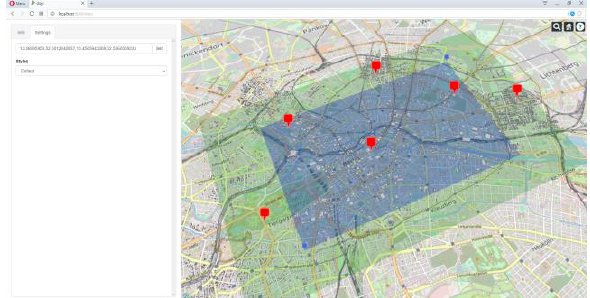
Figure 10. I3S nodes rendered in Cesium. Blue rectangle: requested bounding box. Green rectangle: buffer. Red